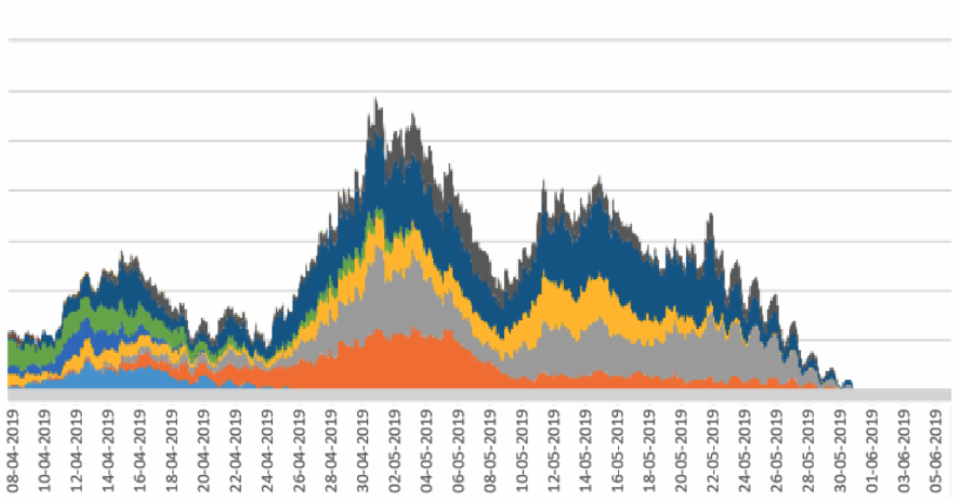
Figure 6. Stacked line graph for aligned periodicity intensities for calves 1–10. Each colour represents a different calf.